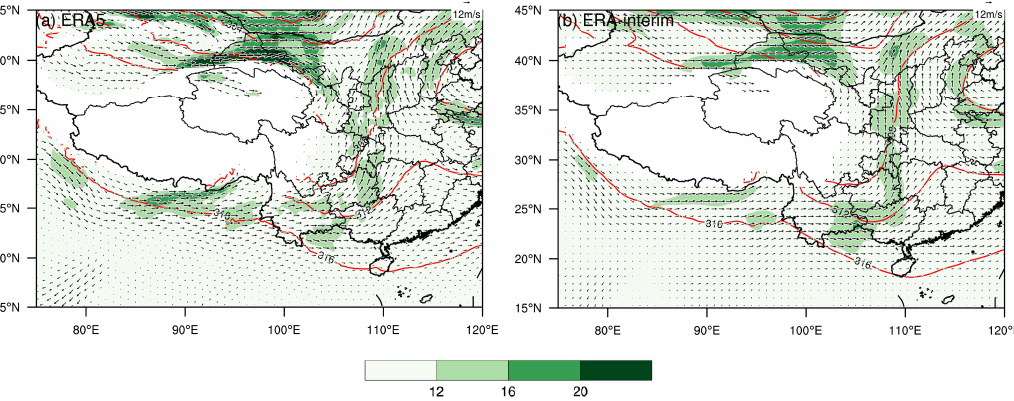
Figure 8. Wind fields (vectors, m · s − 1 ) and height field (contours, dagpm) at 700 hPa, 0600 UTC 2 May, LLJ (shading indicates wind speed over 12 m · s − 1 ), ERA5 reanalysis data ( a ), ERA-interim reanalysis data ( b ).